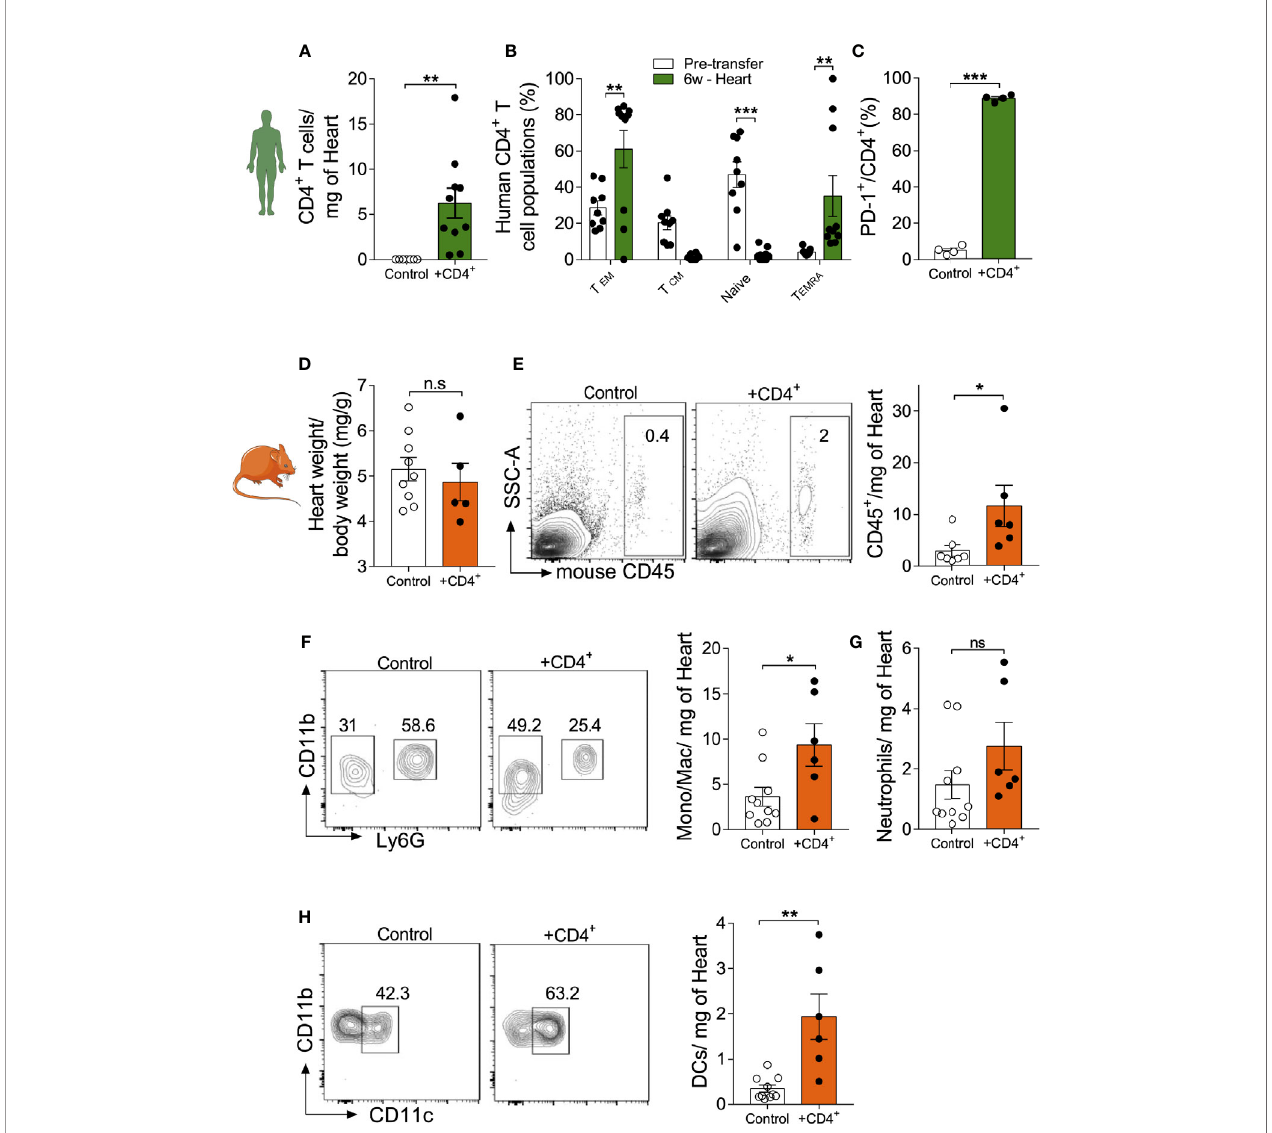
FIGURE 3 | Young mice harboring a senescent-like CD4 + T-cell compartment show signs of myocardial in fl ammaging. Myocardial in fi ltration of transferred T-cells and its impact on baseline tissue in fl ammation. (A) Human CD4 + T cells were detected in the myocardium of NSG-DR1 mice 6 weeks after engraftment. (B) CD4 + T cells found in the myocardium mainly presented a terminally differentiated phenotype, classi fi ed as CCR7 - CR45RO - , while naïve and central memory phenotypes were largely reduced after transfer. (C) Increased frequency of heart PD-1 + T cells versus pretransfer values. (D) Heart weight to body weight was measured in control and CD4 + T cell-transferred NSG-DR1 mice. (E) FACS plots depict the frequency of heart mouse leukocytes (live CD45 + ) in control and adoptively transferred mice. The bar graph shows the number of heart leukocytes normalized per tissue weight. (F) Gating strategy for cardiac monocytes/macrophages (CD11b + Ly6G - ) and neutrophils (CD11b + Ly6G + ). The bar graph illustrates the number of monocytes/macrophages and neutrophils (G) in control and CD4 + T cell-transferred mice per milligram of heart. (H) Cardiac dendritic cells were gated as Ly6G - CD11b + /CD11b + CD11c + events. Control group: Naïve NSG-DR1 mice. CD4 + group: NSG-DR1 mice transplanted with human CD4 + T cells. The bar graphs display the group mean values, the SEM and the distribution of each individual value. Green bars represent parameters measured on human CD4 + T cells, and orange bars represent mouse endogenous leukocyte parameters. Statistical analysis in (B) : two-way ANOVA followed by multiple t tests, *** P < 0.001 and ** P < 0.01, in all other panels: two-tailed unpaired t test, ** P < 0.01 and non-signi fi cant (n.s) P>0.05. *P <